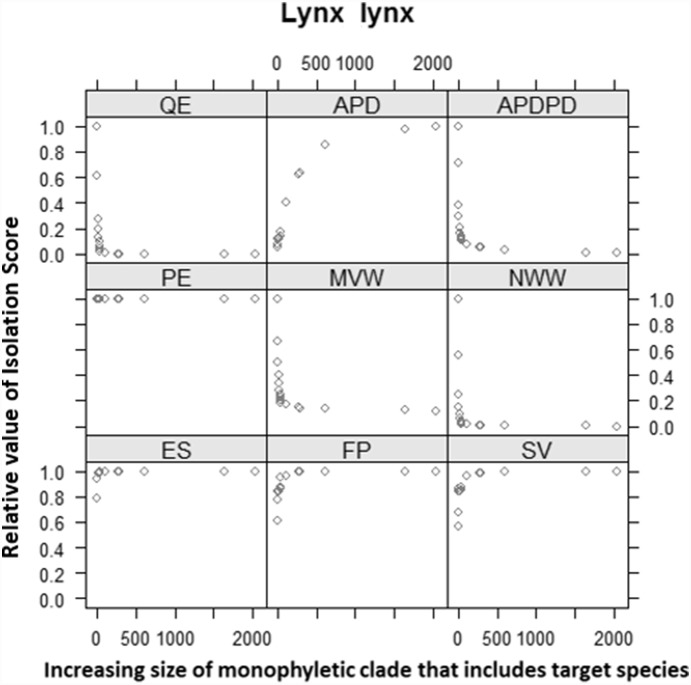
Eight different metrics of evolutionary isolation for a randomly chosen species (Lynx lynx) calculated on increasingly large complete clades that contain this target species.One metric APD appears twice, once in its original format and once as “APDPD,” where it is divided by the total PD of clade. All evolutionary isolation scores were standardised by dividing by the maximum score for that specific isolation metric. Metric acronyms are described in Table 1.